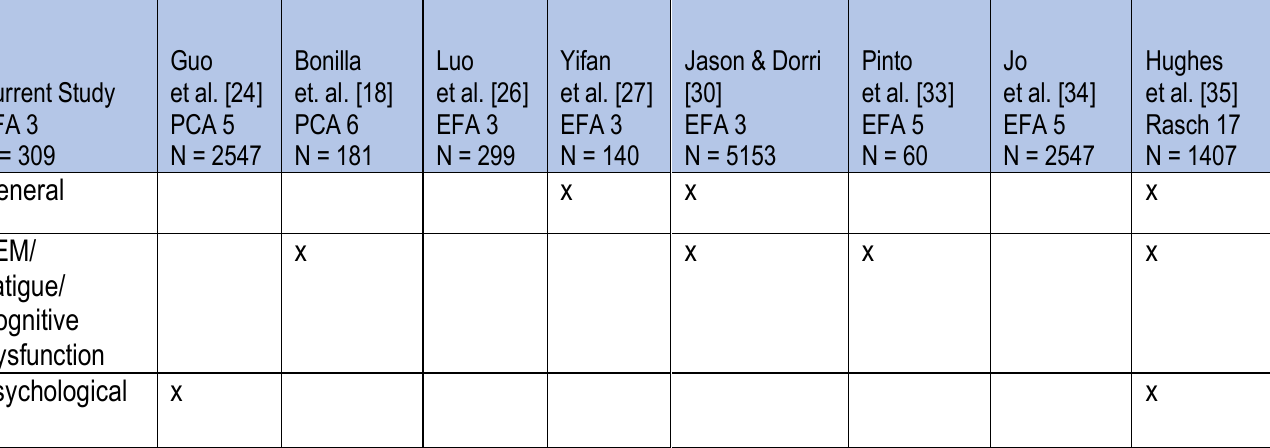
Table 5. Domain overlaps of this EFA and prior studies of Long-COVID symptom